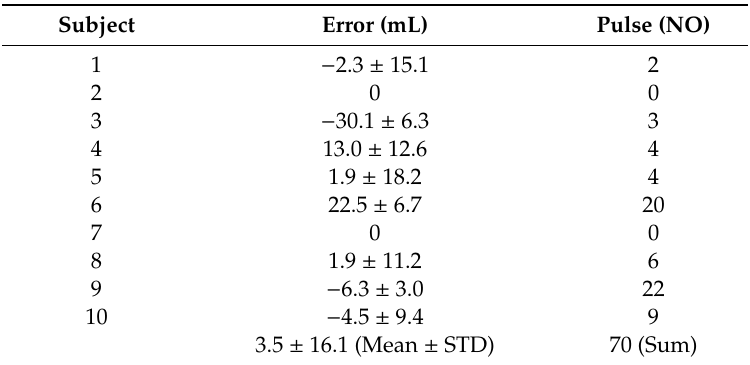
Table 4. The statistic error of SVs between the medis ® CS2000 device and our ICG device using the PPG pulses with middle SQI.